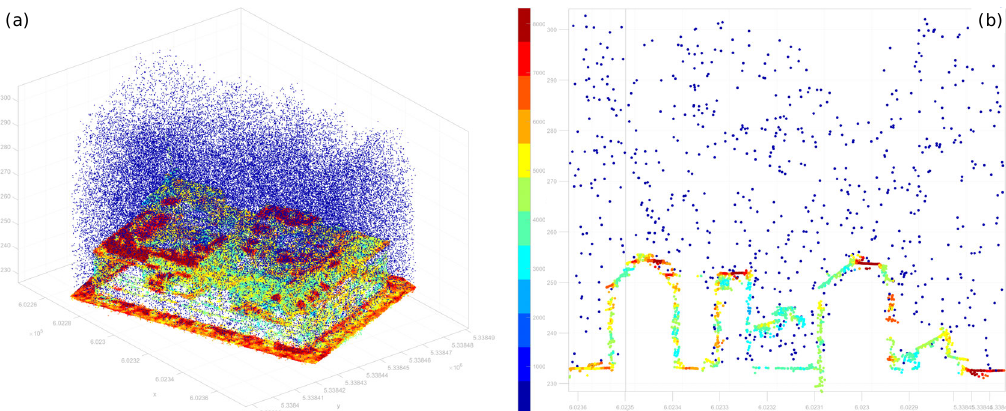
Figure 4. Unfiltered SPL100 3D point cloud of a building block within the city test area colored by intensity [DN]; (a) perspective view of the entire building block, (b) section view of a subarea